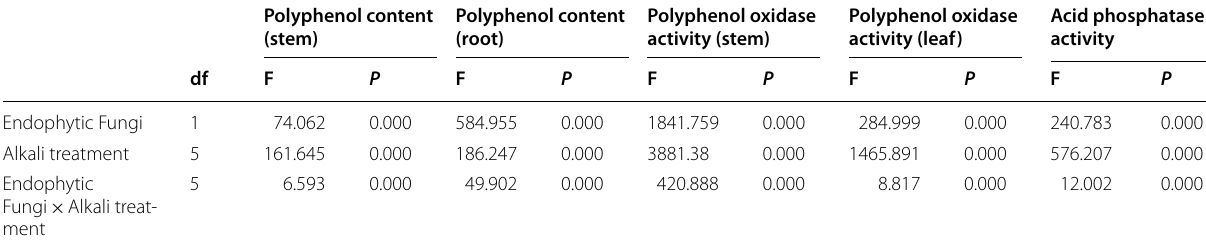
Table 2 Two-factor analysis of effect of endophytic fungi on the polyphenol content, and the activities of polyphenol oxidase and acid phosphatase in Hordeum bogdanii under alkali